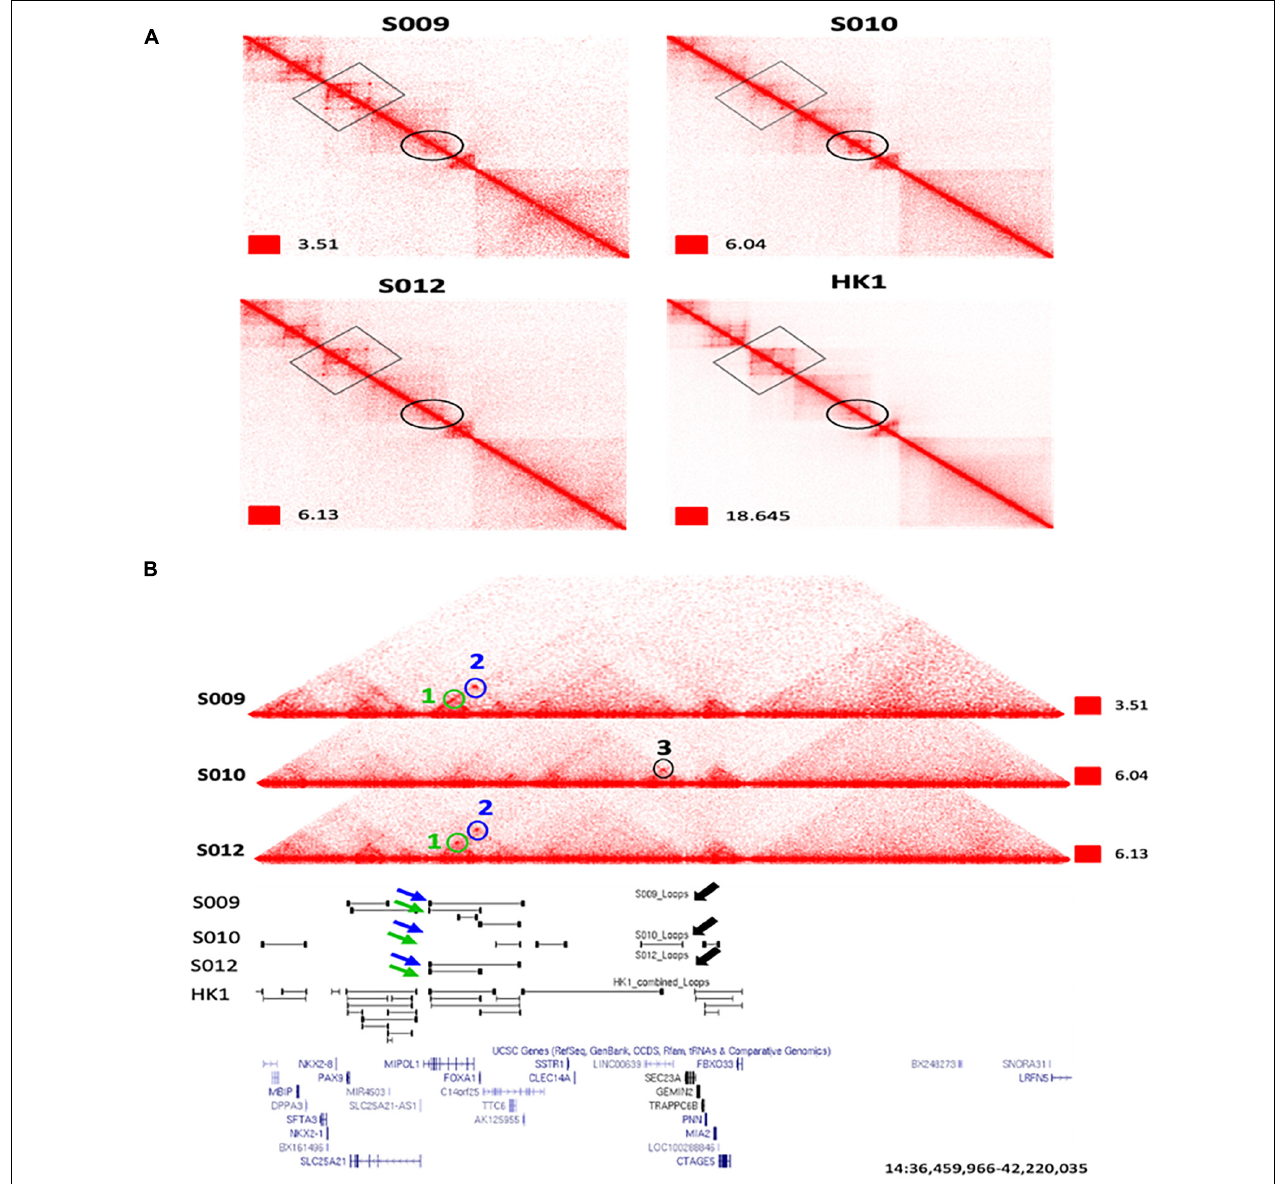
FIGURE 3 | An example of extensive heterogeneity between patients in the chromatin interactome in nasopharyngeal cancer at the FOXA1 and MIPOL1 genes. (A) Zoomed view of Biop-C Juicebox-visualized heatmaps of S009, S010, and S012 showing patient heterogeneity in chromatin interaction at the FOXA1 and MIPOL1 genes. (B) UCSC genome browser (Kent et al., 2002) screenshots of genomic coordinates chr14: 36,459,966–42,220,035. Loops 1 and 2 are present in S009 and S012, while loop 3 is present only in S010. Loop 1, loop 2, and loop 3 are represented in green, blue, and black colors, respectively.